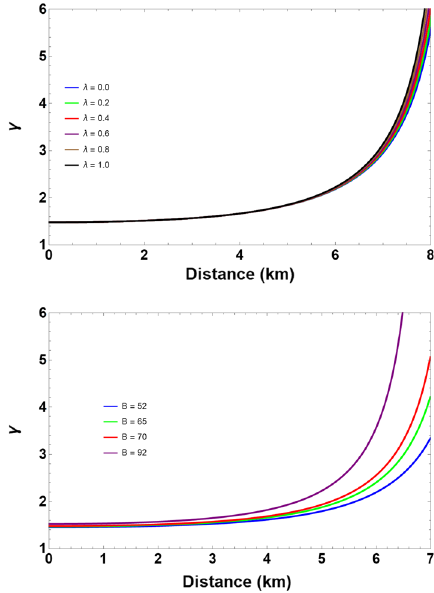
Fig. 4 The plot for adiabatic index, γ , for an interacting quark EoS with the same set of parameters in Figs. 1 and 2,